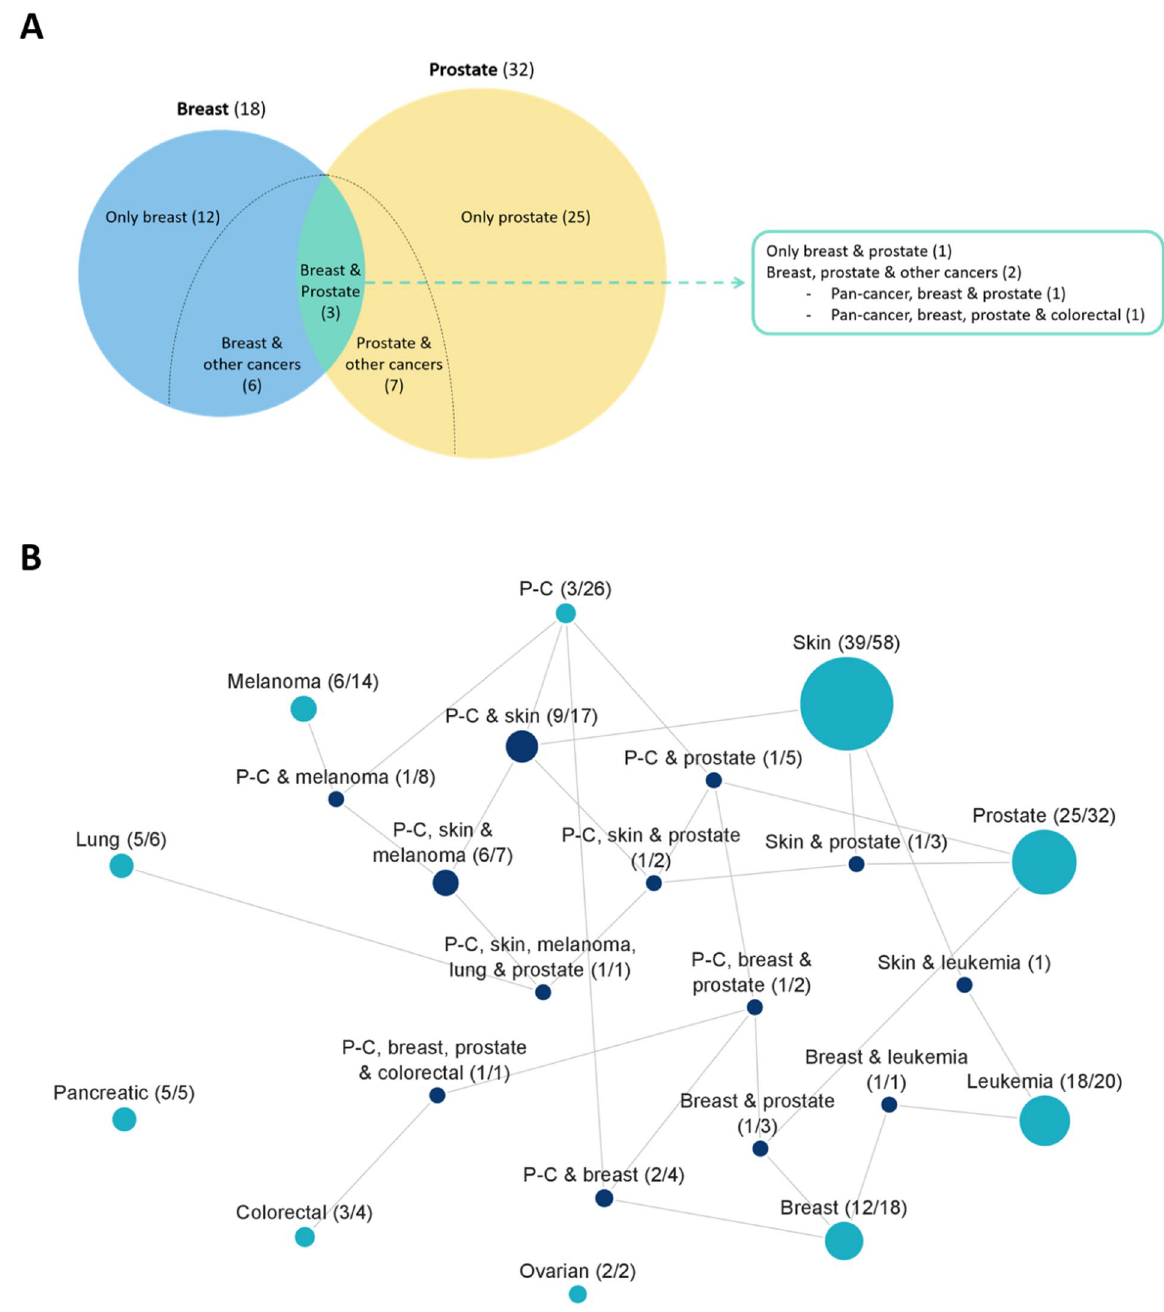
Figure 5. Number of significant regions per cancer-type combination. ( A ) Venn diagram of the 18 significant genomic regions in breast cancer and the 32 significant regions in prostate cancer with 3 overlapping regions between these two cancer types, as an example of the unique and shared genetic signals between cancer types. ( B ) Partitioning of the 145 significant cancer genomic regions by the combination of cancer types in which they were found significant. Each node in the graph represents a combination of cancer types. Two nodes are connected when one combination is a direct subset of the other. Each node is labeled with two numbers: the number of significant regions matching the exact combination of cancer types represented by the node (e.g. 12 genomic regions that are unique to breast cancer), and the total number of significant regions matching any combination of cancer types that includes this combination (e.g. overall 18 regions associated with breast cancer, including 6 regions shared with other cancers). Node sizes reflect the number of significant regions that match the combinations exactly. Nodes representing combinations of more than one cancer type are colored dark blue. Pan-cancer is abbreviated as